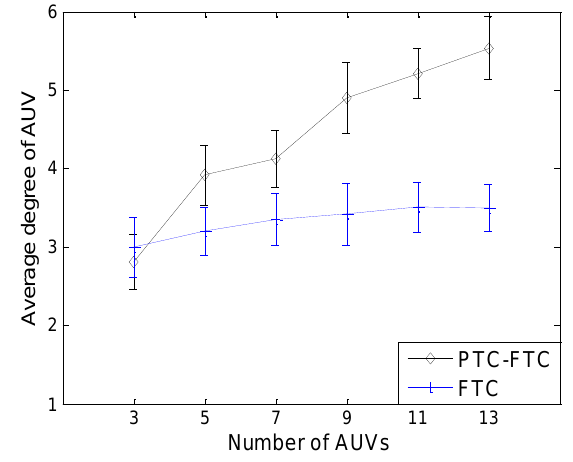
Figure 14. The average node degree of PTC-FTC and FTC.